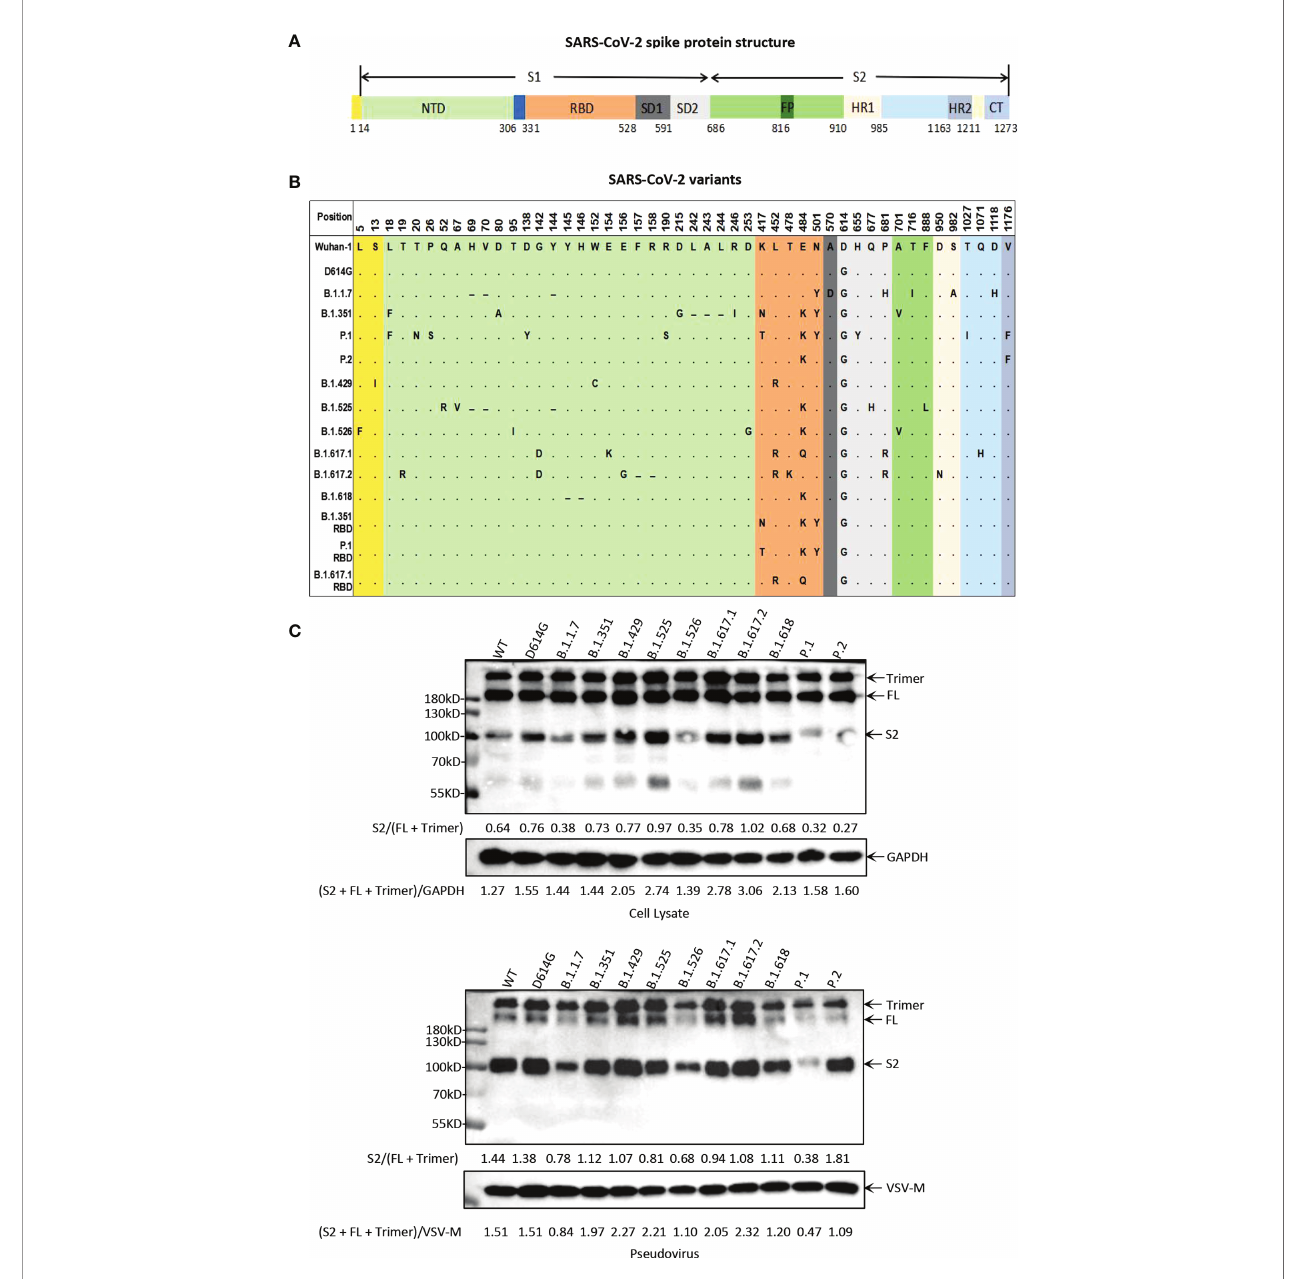
FIGURE 1 | Illustration of the major circulating SARS-CoV-2 variants. (A) Schematic diagram of SARS-CoV-2 spike protein structure. NTD, N-terminal domain; RBD, receptor-binding domain; SD, subdomain; FP, fusion peptide; HR1, heptad repeat 1; HR2, heptad repeat 2; CT, cytoplasmic domain. (B) Mutation site at the amino acid level in the viral spike protein-coding region identi fi ed in SARS-CoV-2 variants. All of the pseudoviruses in this study were generated in the background of Wuhan-1 strain. In the mutation map, a dot ( ∙ ) indicates the same amino acid in that position as Wuhan-1 strain, and a dash (-) indicates a deletion. (C) Analysis of SARS-CoV-2 variants S protein expression and particle incorporation by Western blotting using a monoclonal antibody directed against SARS-CoV-2 S2 subunit. GAPDH (cell lysates) and VSV-M (particles) served as loading controls. The full-length S protein band is about 180 kDa, the S2 protein band is about 90 kDa, and the bands above 180 kDa represent trimeric S protein. Shown are representative blots from three